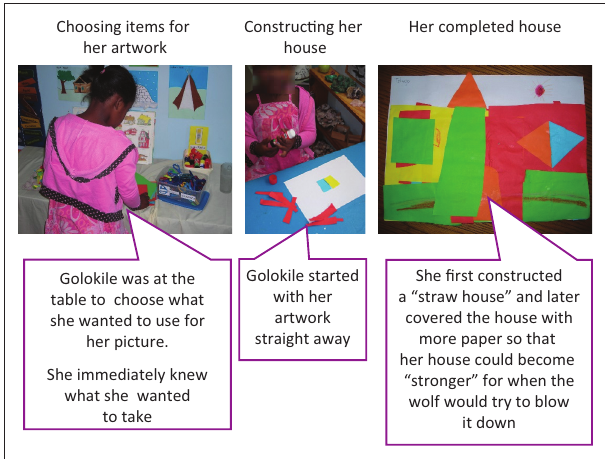
FIGURE 1: Golokile working on her